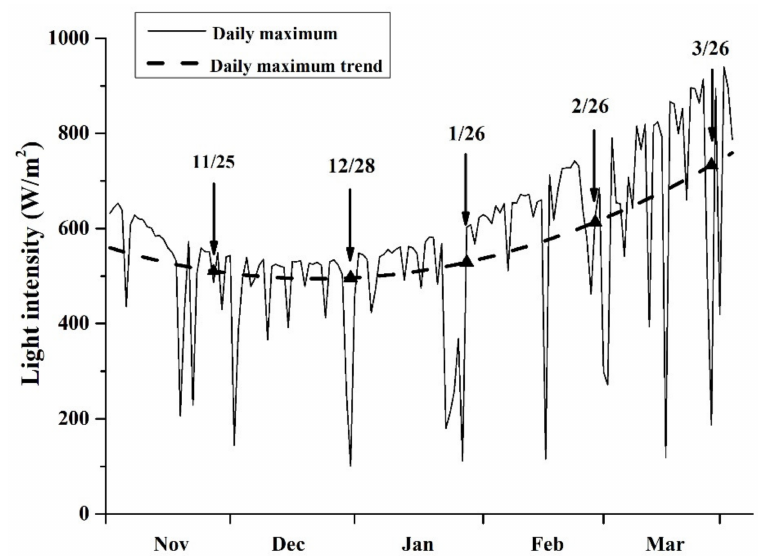
Figure 2. The hourly solar light intensity from November 2020 to March 2021 in Jimo sea area. The solar light intensity values were obtained from the simulated solar short-wave radiation data. The points marked in the figure were the sampling date.